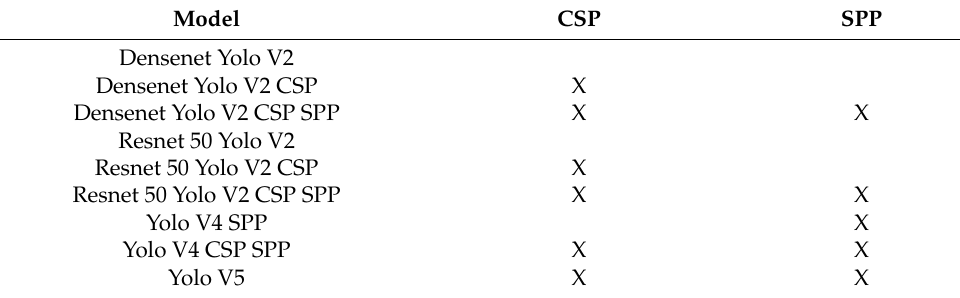
Table 1. Experimental